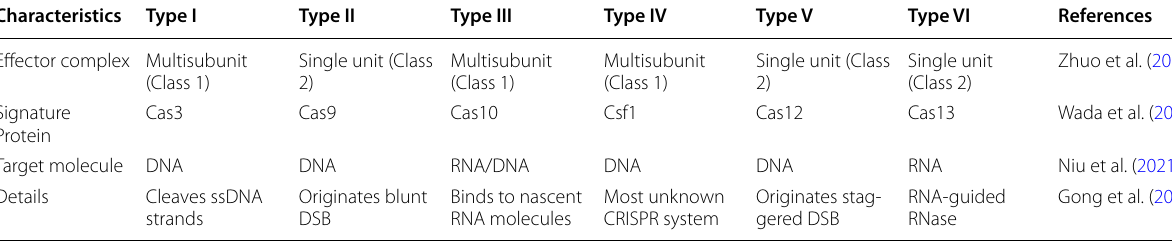
Table 6 Characteristics of different types of CRISPR systems Characteristics Type